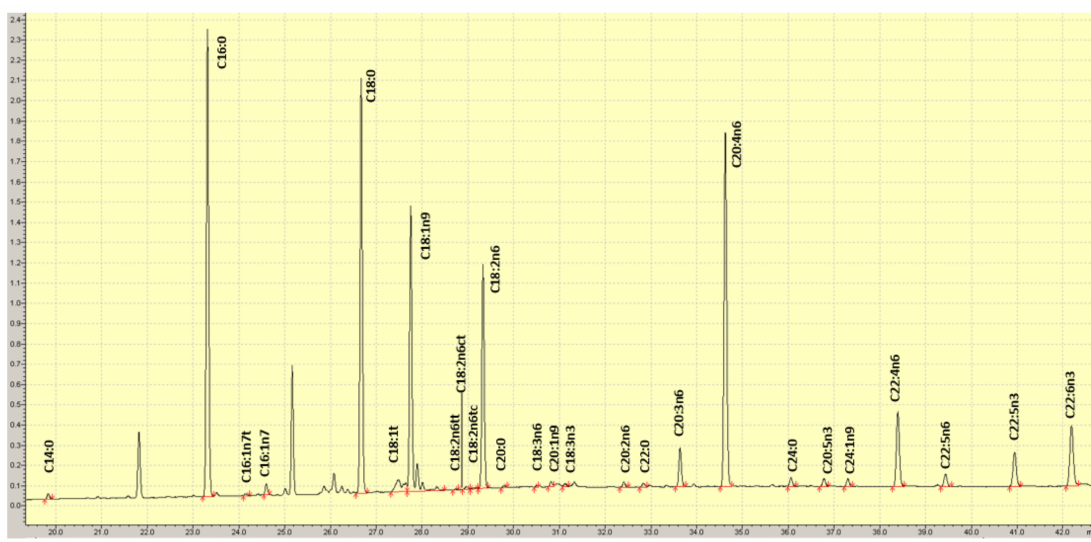
Figure 2. Example of a chromatogram of RBC fatty acid methyl